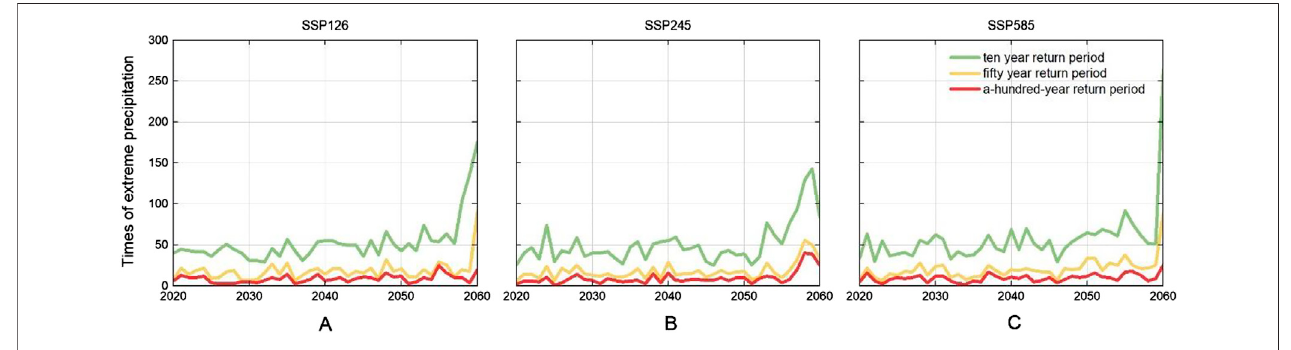
FIGURE5| Extreme fl oodfrequencyinQinghaiprovincefrom2020to2060. (A) 10/50/100-yearreturnperiod fl oodfrequencyundertheSSP126scenario; (B) 10/ 50/100-year return period fl ood frequency under the SSP245 scenario; and (C) 10/50/100-year return period fl ood frequency under the SSP585 scenario.